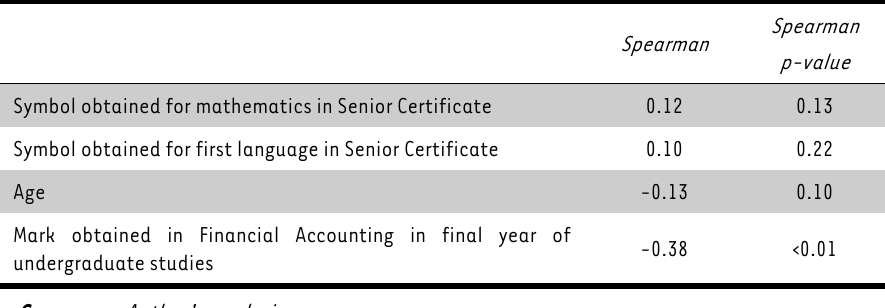
TABLE 4: Correlations with drop in